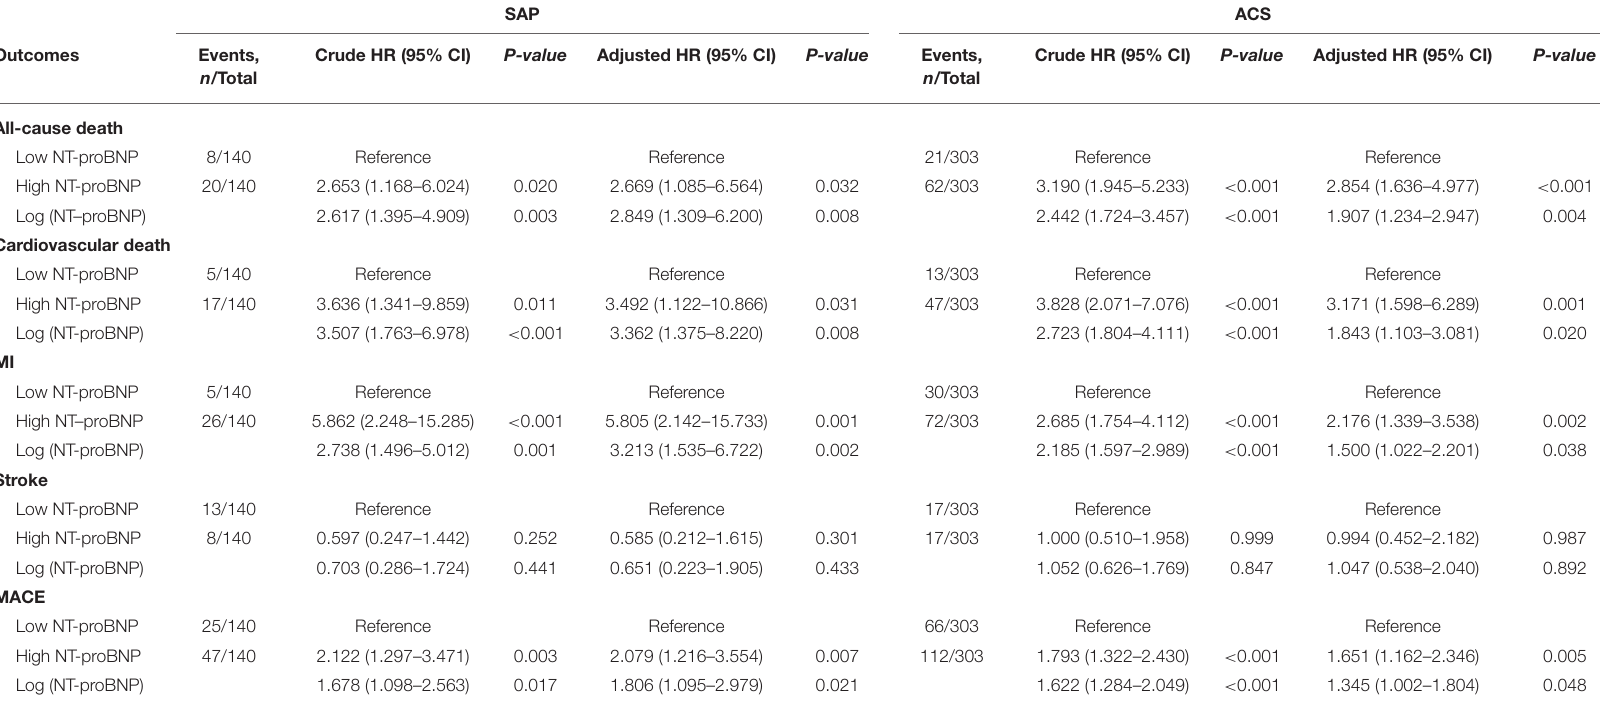
TABLE 3 | Subgroup analysis of the association between NT-proBNP levels and endpoints according to clinical presentation.